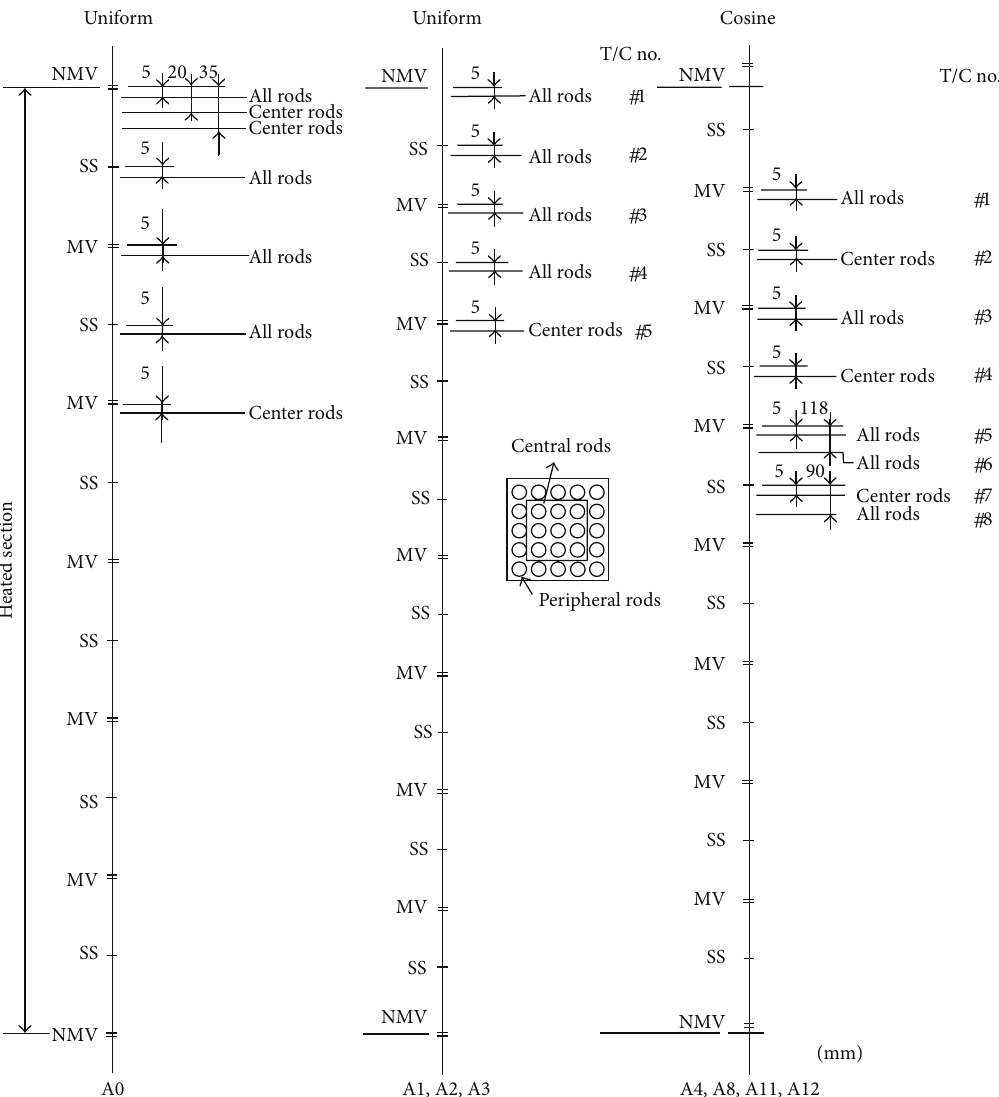
Figure 13: Locations of thermocouples for test